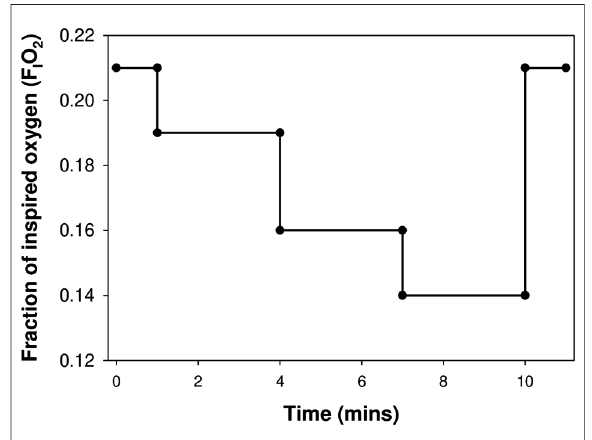
FIGURE 1 The testing protocol: inspired oxygen was reduced in 3 steps from 21% (baseline) to 14%, with each step lasting for 3 min, before the infant was returned to room